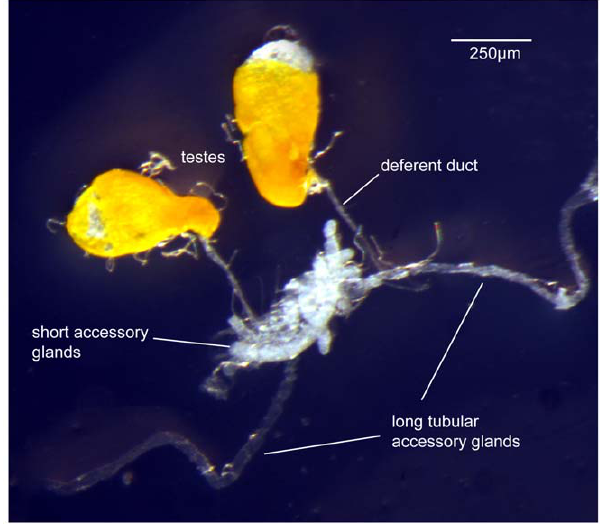
Figure 1. Dissection of the male reproductive tract including the testes and accessory